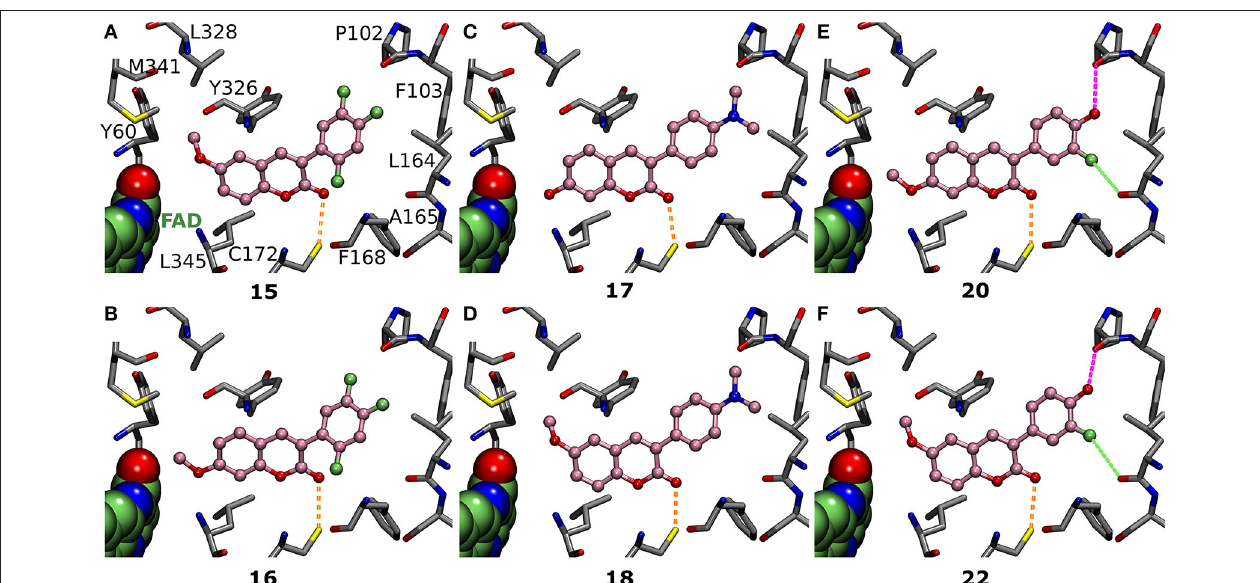
FIGURE 6 | The effects of R1 and R2 substituents are dependent on the 3-phenyl ring substituents. (A) Derivatives 15 ( Figure 2 ; IC 50 of 292nM; Table 1 ) and (B) 16 ( Figure 2 ; IC 50 of 1433nM; Table 1 ) both have fluorine groups at R4, R6, and R7 positions, but switching the coumarin ring’s R1-methoxy into the R2 position reduces the inhibition by whopping 1141nM. In contrast, with (C) 17 ( Figure 2 ; IC 50 of 384nM; Table 1 ) and (D) 18 ( Figure 2 ; IC 50 of 617nM; Table 1 ), the R1-methoxy does not elicit as strong inhibition as the R2-hydroxyl due to the overall coumarin ring alignment dictated by the 3-phenyl’s R5-dimethylamine. The R1/R2-methoxy switch produces a completely opposite effect for (E) 20 ( Figure 2 ; IC 50 of 391nM; Table 1 ) and (F) 22 ( Figure 2 ; IC 50 of 831nM; Table 1 ) than it did for 15 and 16 (panels A,B ); namely, it lowered the inhibition by 440nM ( Table 1 ). For further details, see Figures 1 , 4